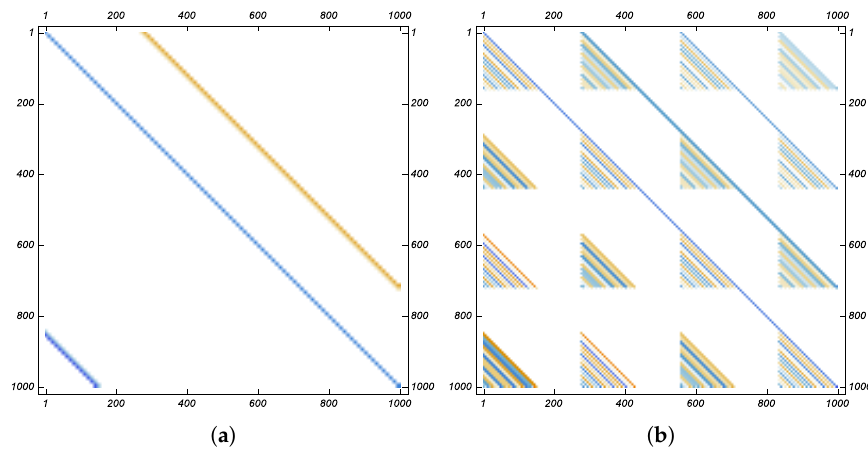
Figure 2. Representation of the ( a ) matrix and ( b ) inverse matrix for Example (2), respectively.